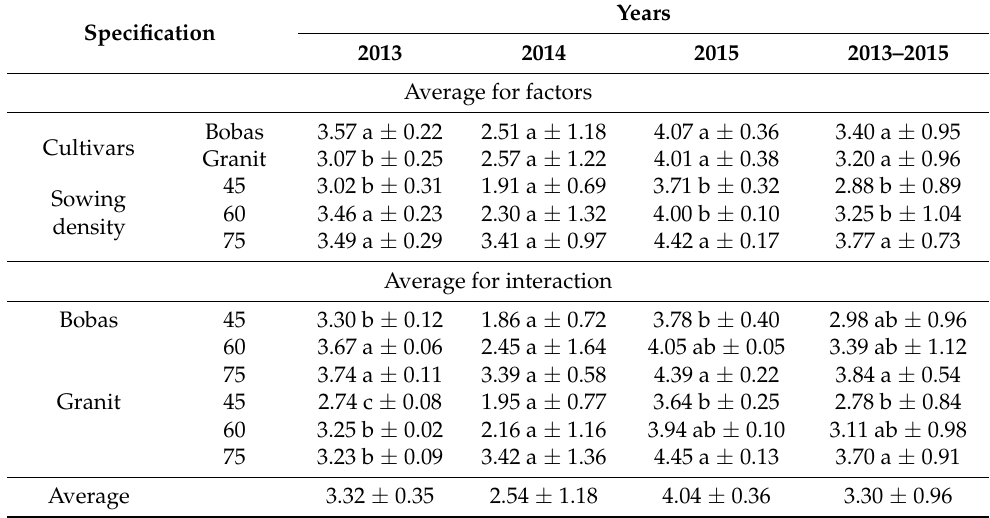
Table 2. The effect of the examined factors on seed yields (t ha − 1 ) in the years of research 2013–2015. Specification